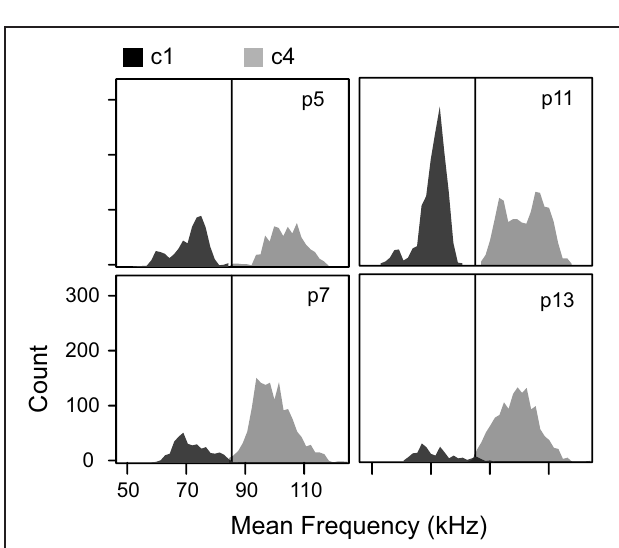
FIGURE 6 | Mean frequencies of the two clusters without frequency steps at each age. The low frequency cluster (c1) and the high frequency cluster (c4) had distinct distributions of mean frequency. The black vertical line at 85kHz marks the boundary set for the mouse syllable classification calculator